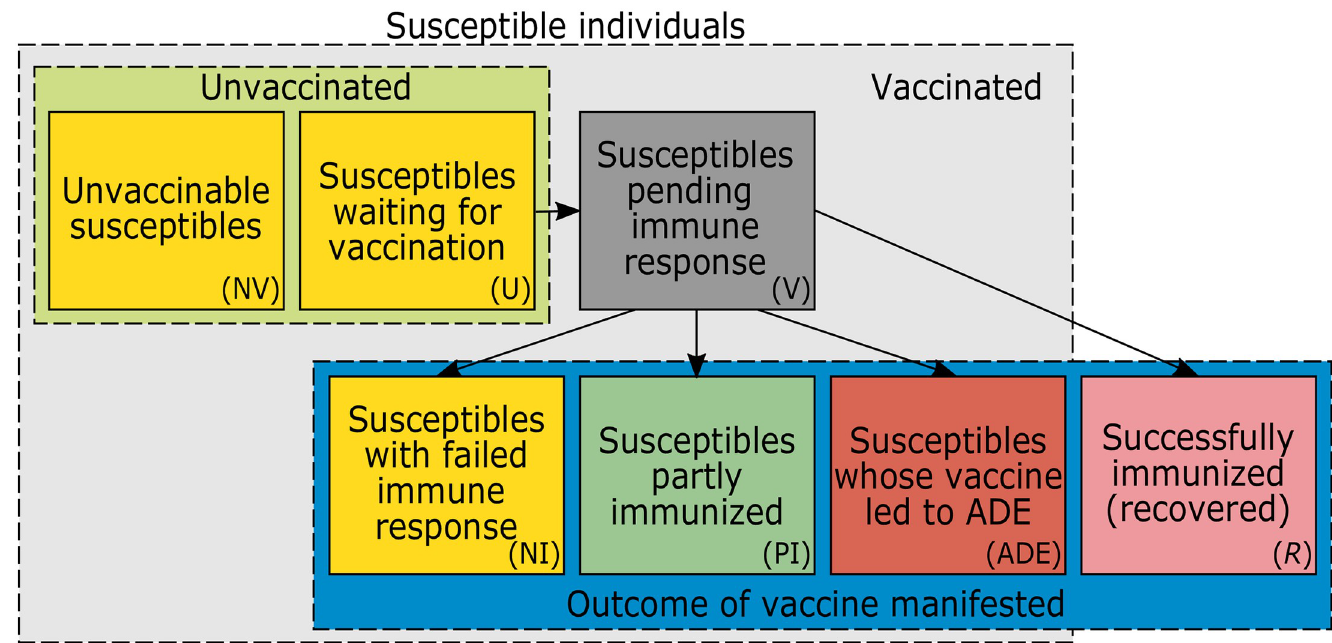
Fig 2. Groups of susceptible and immunized individuals. Schematic representation of different compartments of susceptible individuals. Unvaccinated susceptibles are either unvaccinable (NV) or wait to be vaccinated (U). Vaccinated susceptibles (V) remain susceptible immediately after vaccination. After the vaccination outcome manifested, they remain susceptible at different levels if immunization failed (NI), only partial immunization was achieved (PI), or they developed ADE. Individuals that are successfully immunized are no longer susceptible ( R ). Arrows show how individuals move between groups. All susceptibles can be infected (not